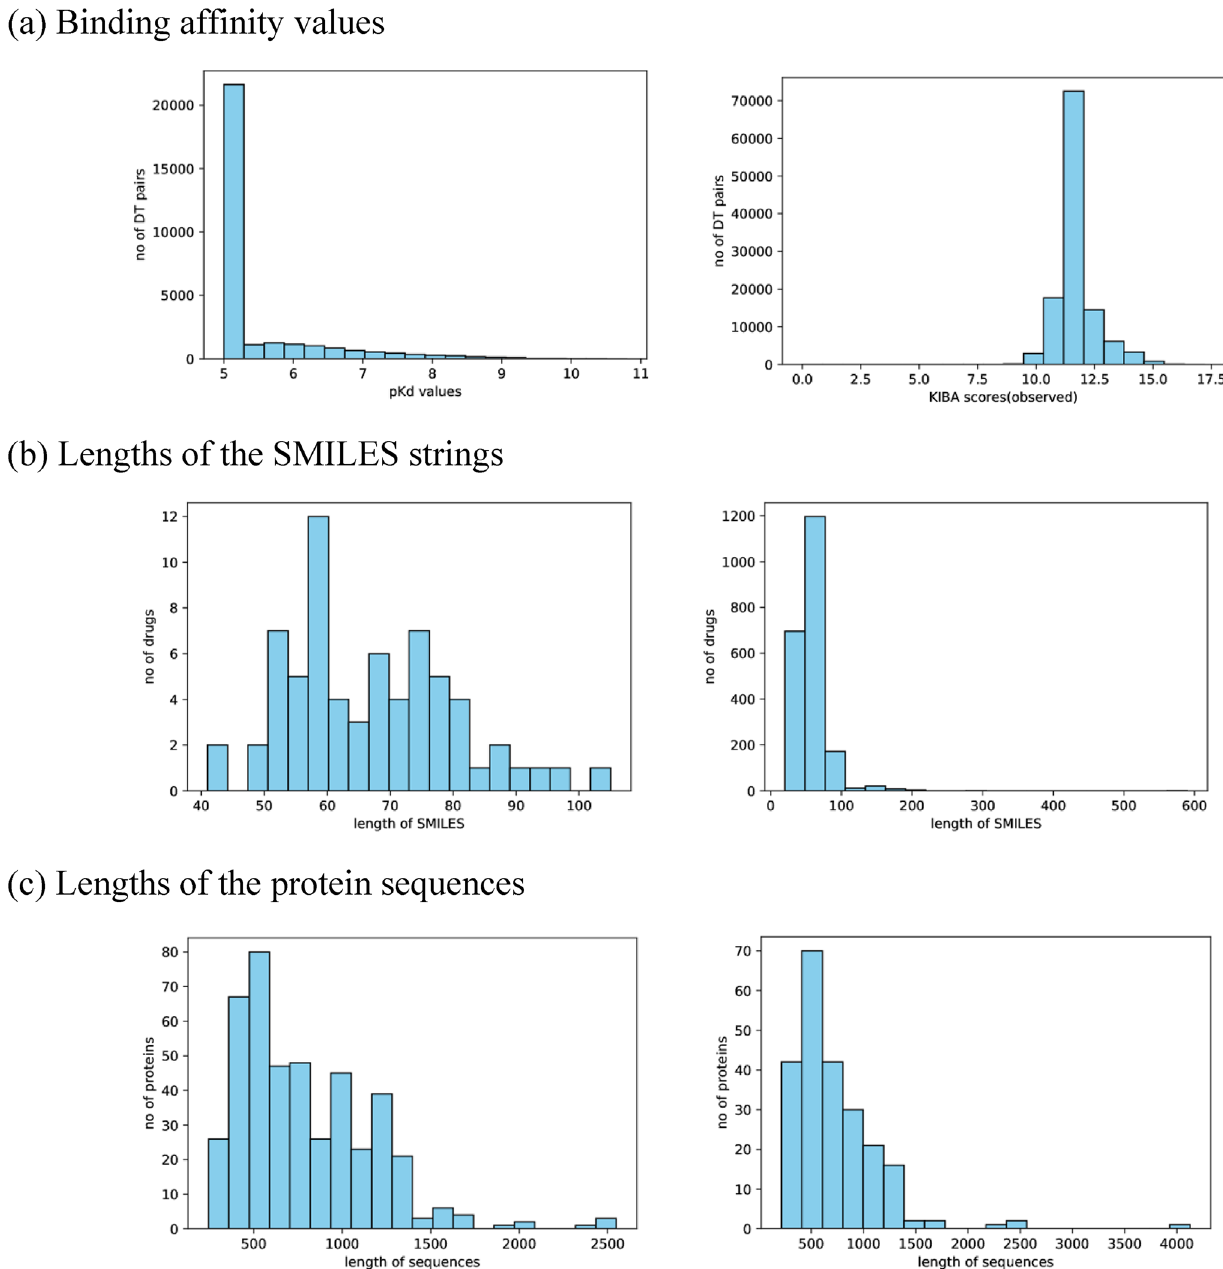
Figure 2. Summary of the Davis dataset (left panel) and KIBA (right panel) dataset. ( a ) Distribution of binding affinity values. ( b ) Distribution of the lengths of the SMILES strings. ( c ) Distribution of the lengths of the protein